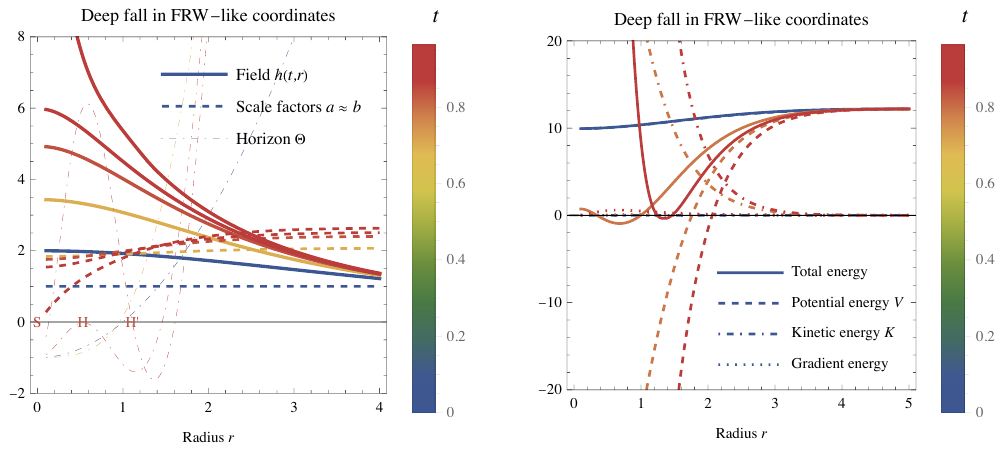
Figure 4 . Numerical evolution in Einstein gravity of the scalar bubble beyond the top of the potential described around eq. (3.8). We work in units in which h the scale factors a ( t, r ) ≈ b ( t, r ) ; the criterion for horizon formation Θ( t, r ) . A black-hole horizon first appears at the point denoted as H. Later a singularity appears inside the horizon at the point denoted as S, while the horizon reaches H 0 . Right : the energy